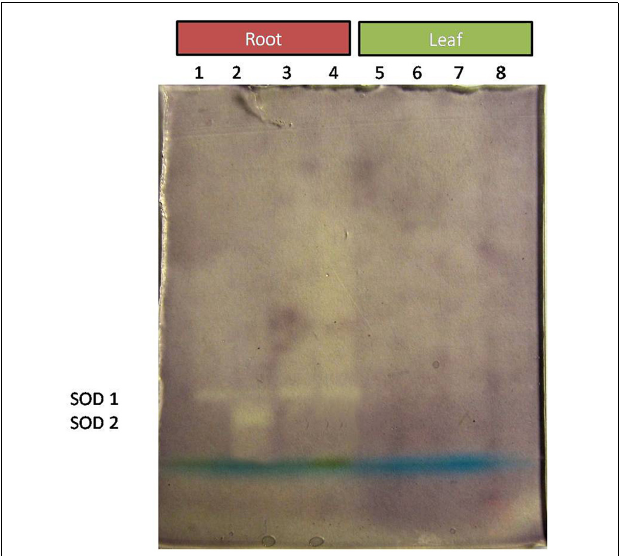
FIGURE 9 | Zymography of SOD isoforms expressed in root and leaves upon bacterial (BHU-AV3) inoculation under salt stress. Lanes 1 and 5 – salt treatment; Lanes 2 and 6 – bacterial (BHU-AV3) inoculation + salt; Lanes 3 and 7 – bacterial inoculation; Lanes 5 and 8 – Control. SOD 1–5 represents number of isoforms expressed.